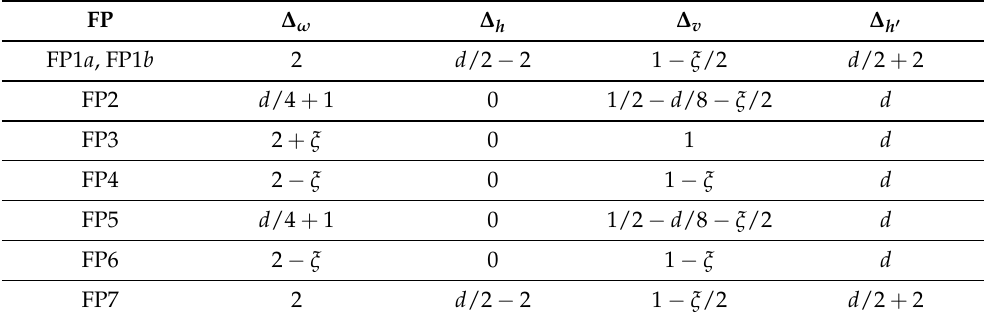
Table 2. Critical dimensions for the fixed points FP1–FP7.